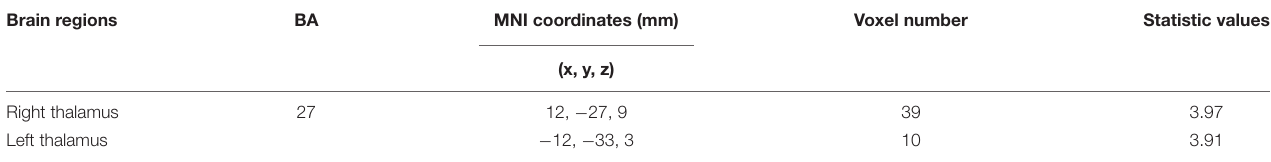
TABLE 2 | FC of right hippocampal CA3 between wife and husband of non-PTSD ( p < 0.05, corrected). Brain regions